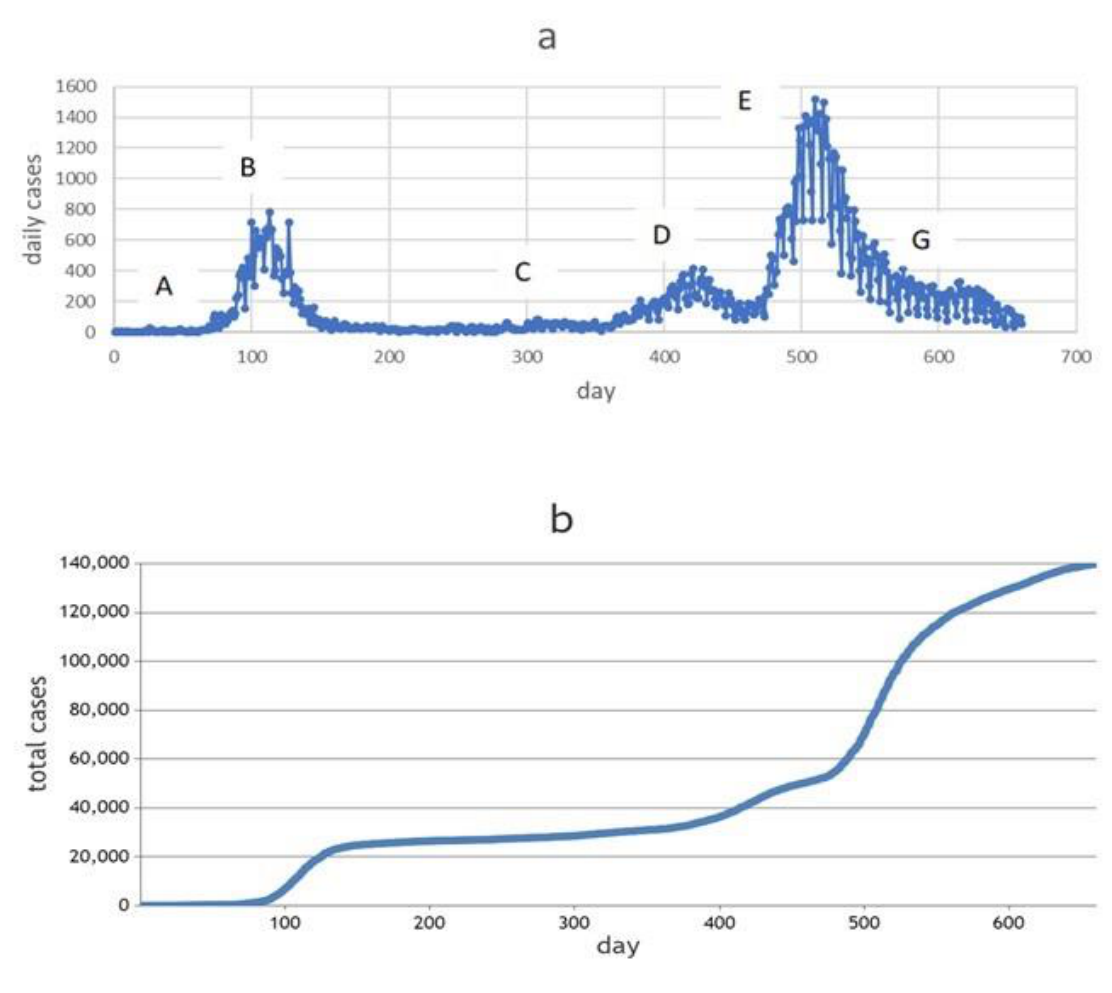
Figure 2. Daily cases ( a ) and total cases ( b ) from 10 March 2020 to 31 December 2021.